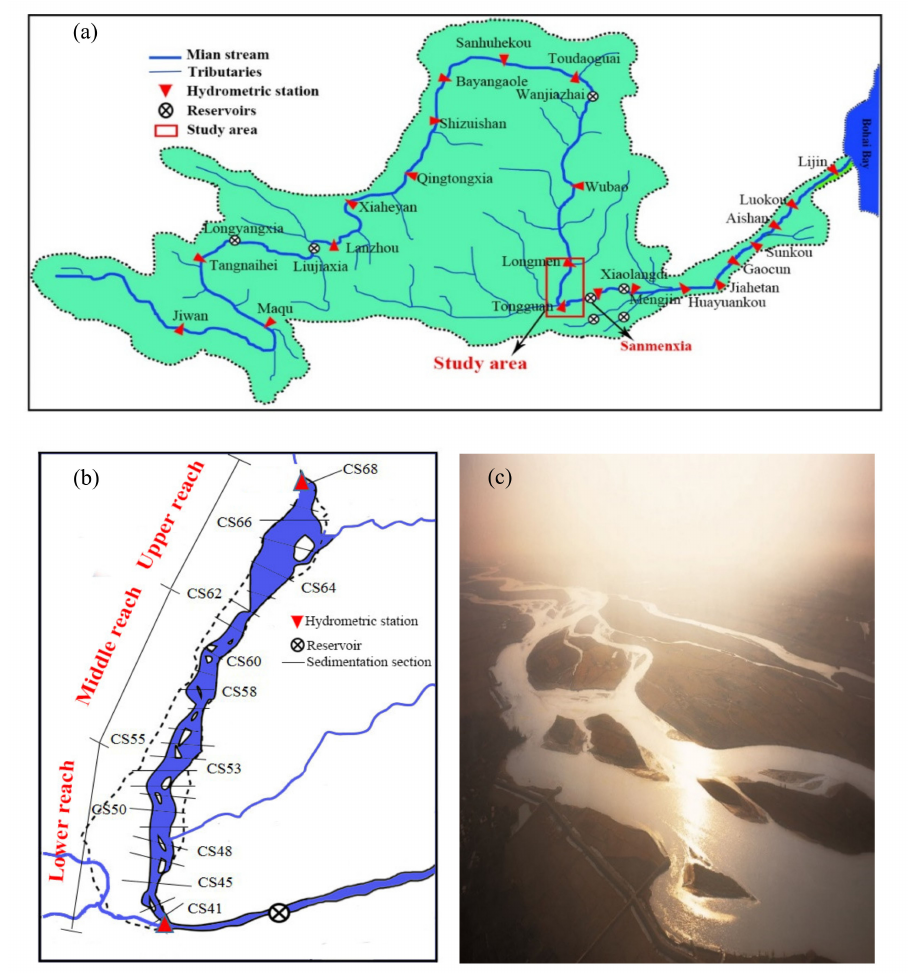
Figure 1. Overview of the study area: ( a ) Yellow River basin; ( b ) sketch of the Xiaobeiganliu reach; ( c ) photograph of the river